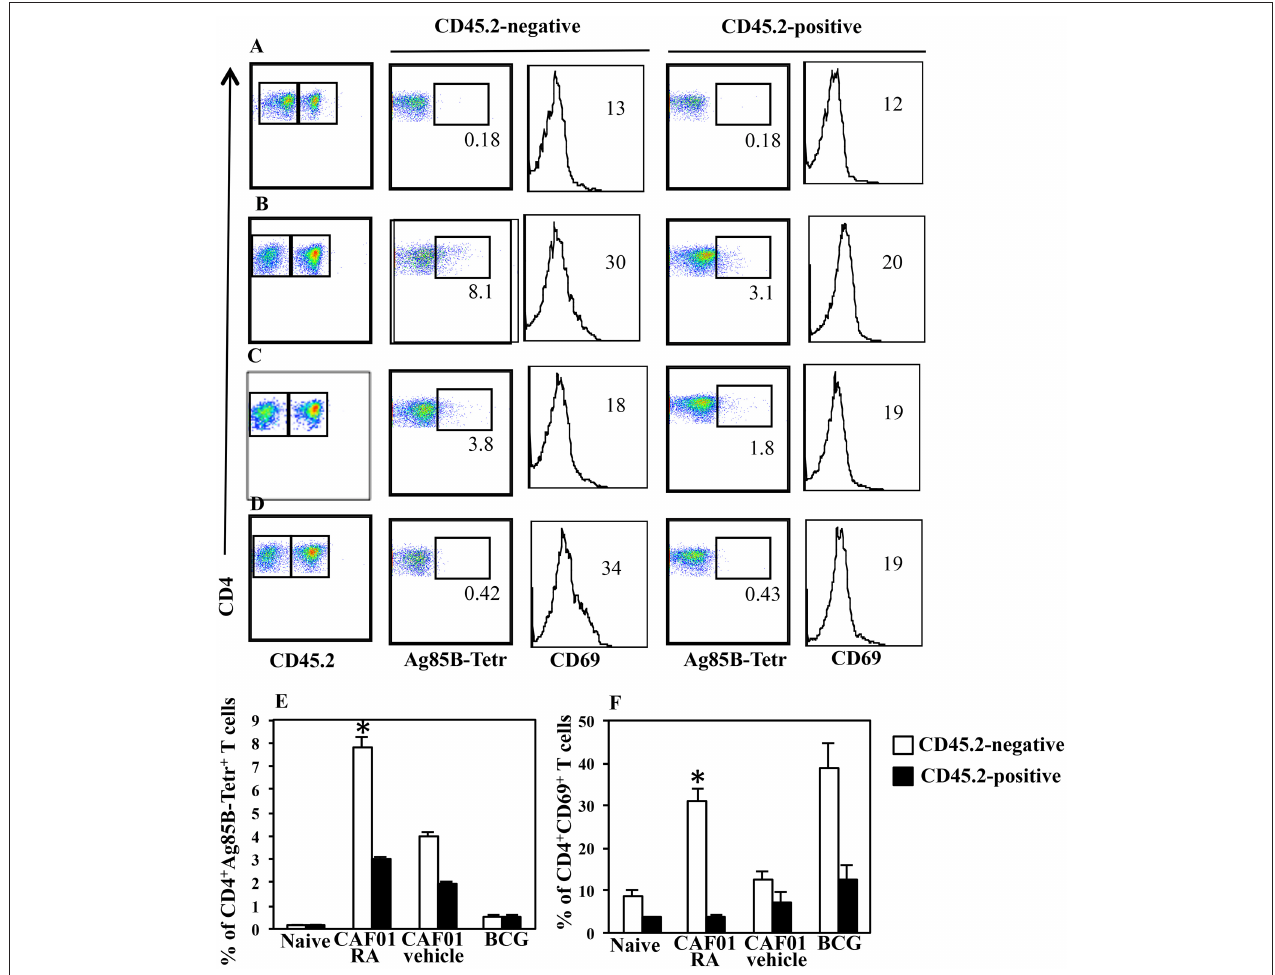
FIGURE 3 | Lung colonization by H56-specific CD4 + T cells in mice parenterally immunized in presence of RA. Untreated naïve CB6F1 mice (A) or mice treated with RA (B) or its vehicle (C) were immunized with CAF01 (125 µ g/dose) and H56 (0.5 µ g/dose) or immunized with BCG (D) as tuberculosis vaccine control. One month after last immunization by combining intravascular (IV) anti-CD45 and ex-vivo Ag85B-tetramers and anti-CD69 staining, the percentage of Ag-specific CD4 + T lymphocytes was evaluated in the lung parenchyma (CD45.2-negative) and intravascular compartments (CD45.2-positive). The graphs show the percentage of CD4 + Ag85B + cells (E) and the percentage of CD4 + CD69 + T cells (F) in the parenchyma and intravascular compartments. Bars indicate the SEM. * p -value < 0.05. One rapresentative experiment is shown of two